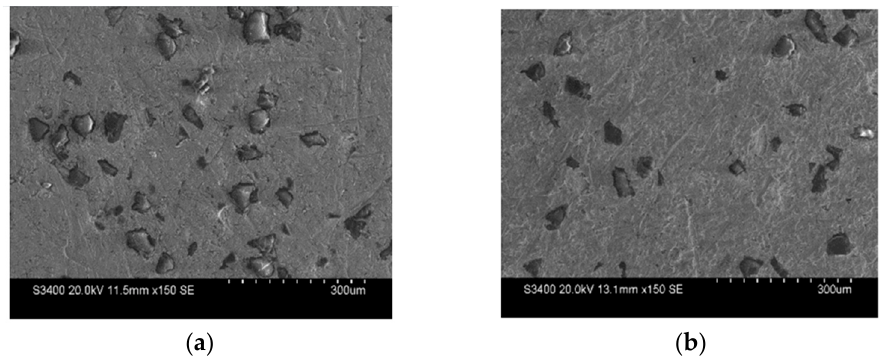
Figure 4. Distribution of abrasive particles on the surface of the dicing blade. ( a ) Part with relatively dense distribution; ( b ) part with relatively sparse distribution.